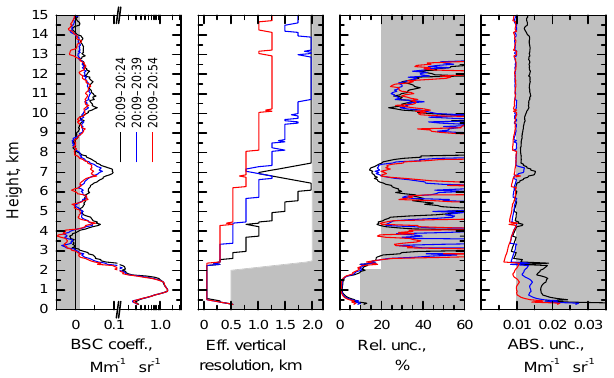
Figure 6. Illustration of the automated averaging procedure. The example Raman backscatter profile at 532nm was measured on 28 May between 20:09 and 20:54UT in Leipzig with the MARTHA lidar. Panels from left to right show the particle backscatter coef- ficient, the effective vertical resolution, the relative statistical un- certainty, and the absolute statistical uncertainty. Gray areas show constraints of the smoothing procedure and of the uncertainties, the black, blue, and red curves show the averaging periods from 20:09 to 20:24, 20:39, and 20:54UT,